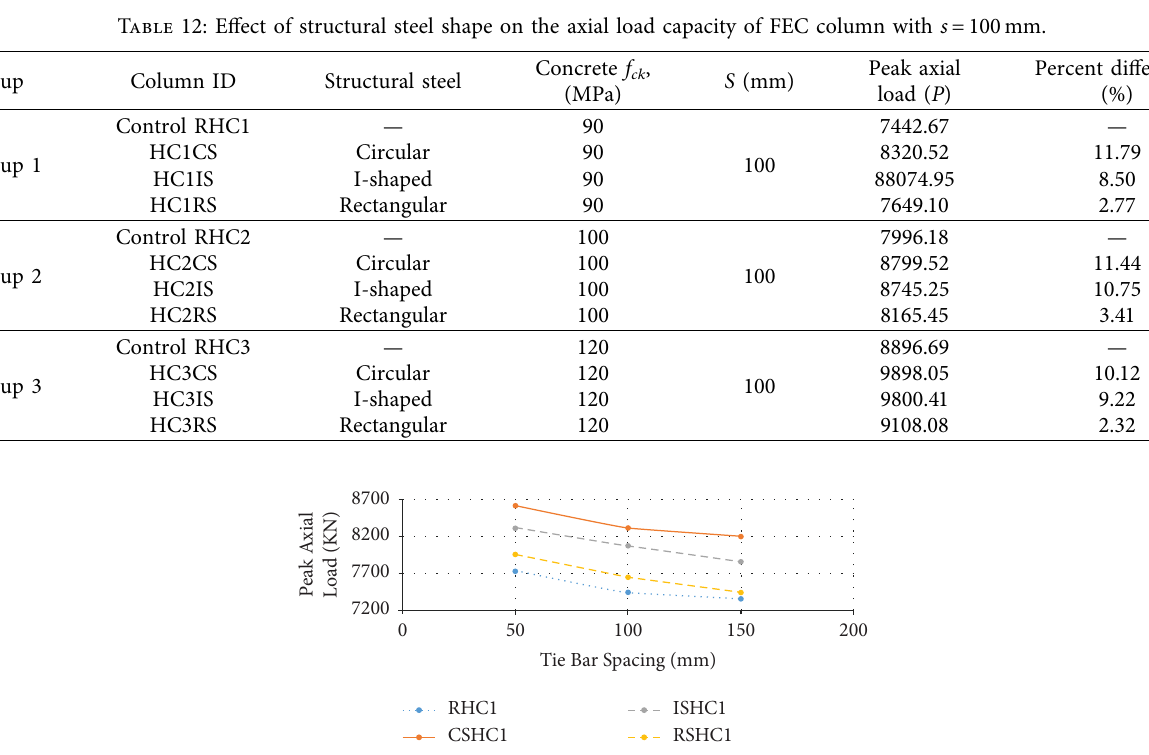
Figure 9: Efect of tie bar spacing on peak axial load of RCC and FECC with 90MPa